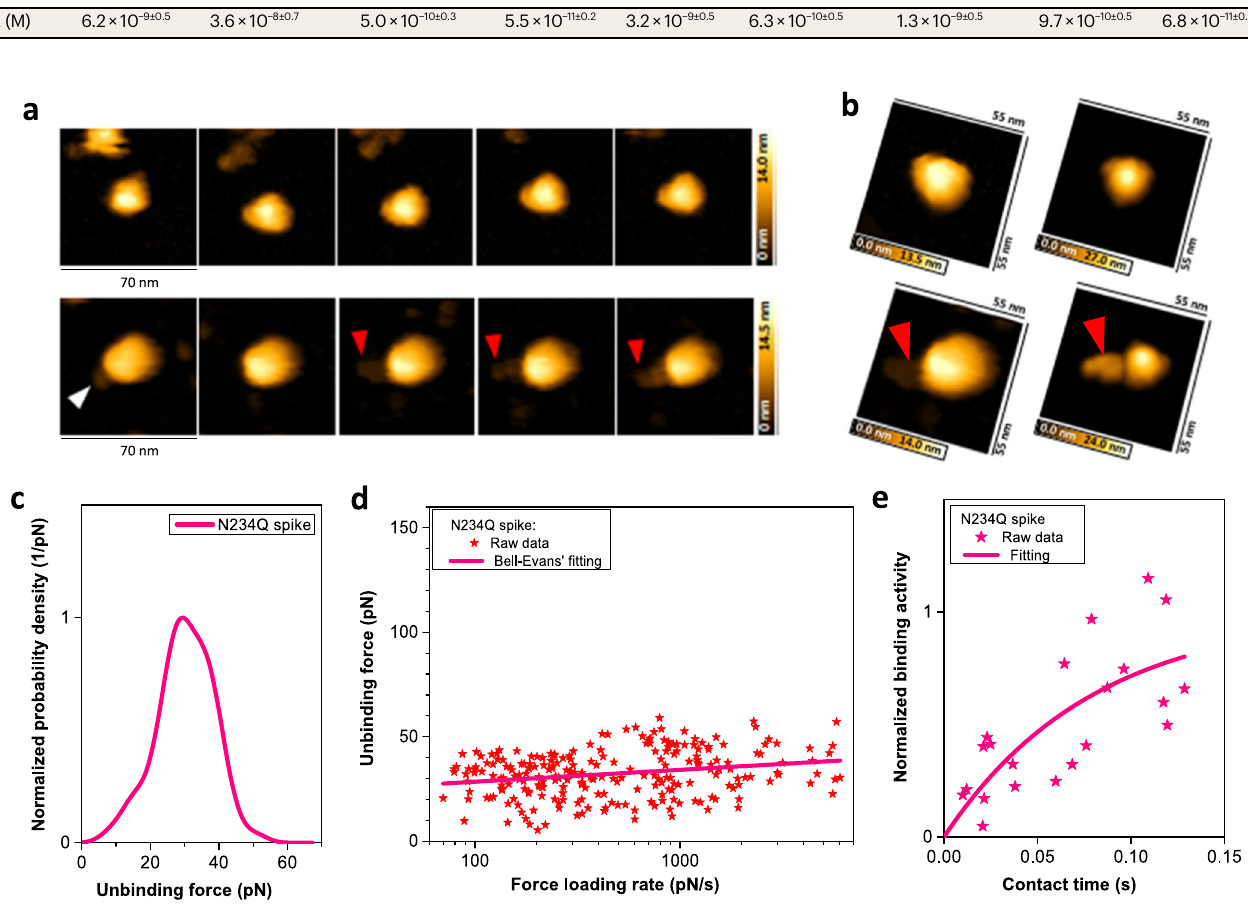
Fig. 4 | Binding of Spike N234Q glycomutant to ACE2. a First row: Single Spike trimerN234Qmutantimagedusinghigh-speedAFM.NodetailsofRBDsorstalkare visible and only small conformational changes were observed. Second row: Single SpiketrimerN234QimagedinbuffersolutioncontainingfreeACE2.OneRBDinthe open conformation (indicated by a white arrowhead) is bound to ACE2 (red arrowhead). b Left panels: AFM images of a single Spike mutant N234Q without ACE2 (upper image) and complexed with ACE2 (lower image). Right panels: simu- lations of a closed Spike trimer without ACE2 (upper image) and complexed with